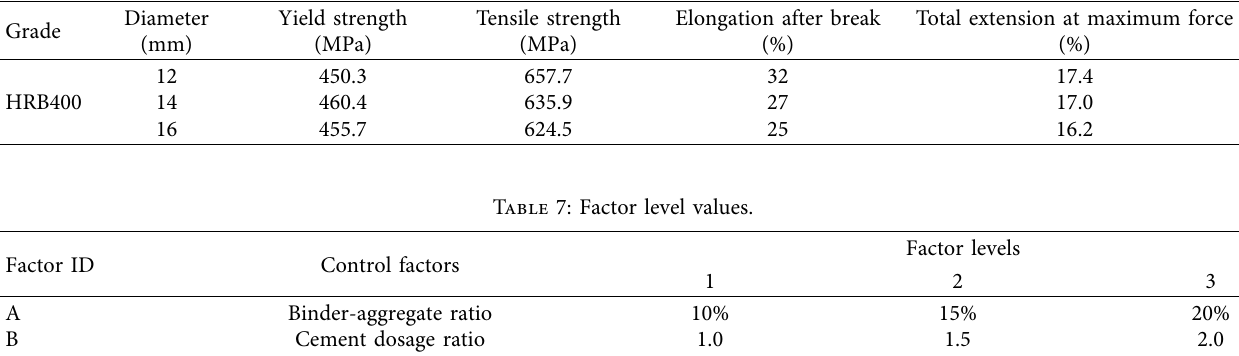
Figure 2: Aggregate grading curves. Table 6: Mechanical properties of steel reinforcement.